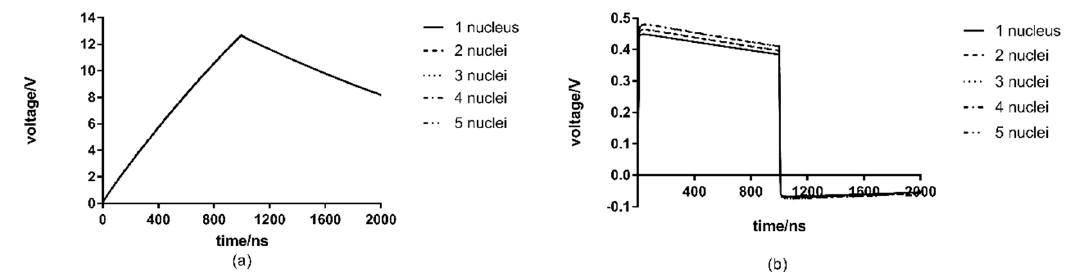
Figure 6. E ff ects of the number of nuclei on transmembrane voltage: ( a ) cell membrane transmembrane voltage ( b ) nuclear membrane transmembrane voltage.